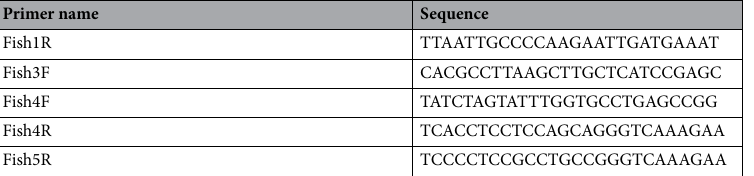
Table 2. Primers used for MT-CO1 DNA polymerase chain reaction and sequencing. F: forward primer. R: reverse primer. The direction of F and R is based on the MT-CO1 gene